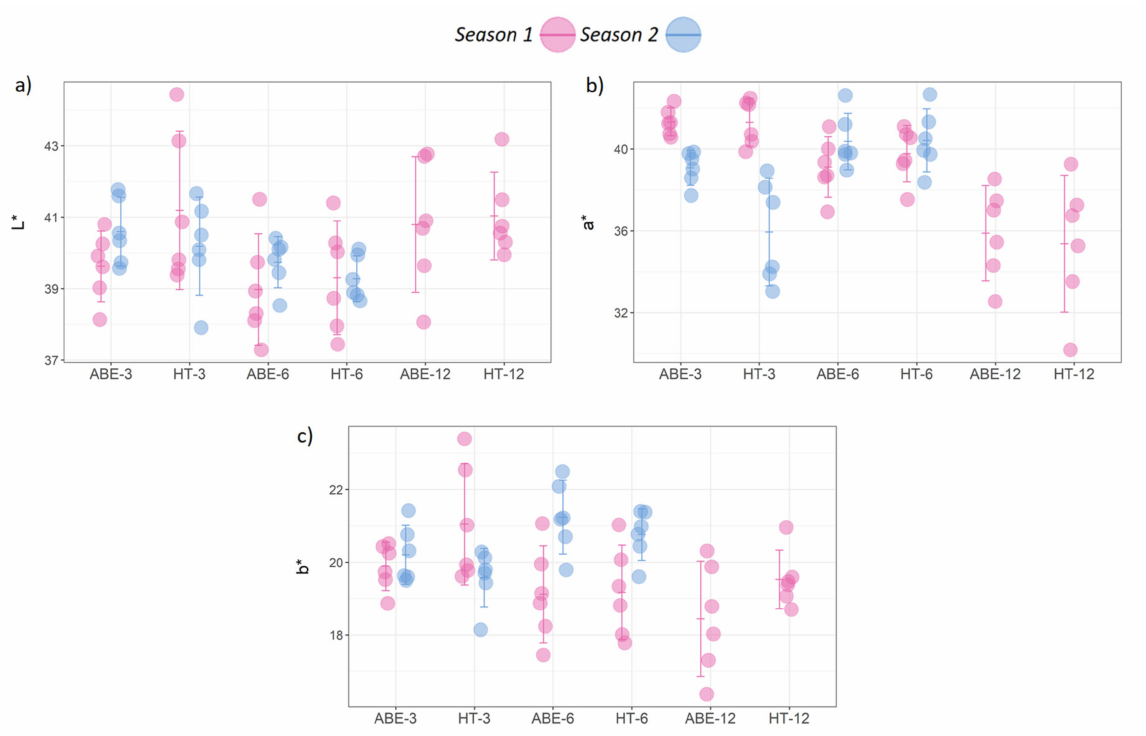
Figure 7. Effect of thinning regime and crop load on fruit color parameters: ( a ) L *, ( b ) a * and ( c ) b * values (error bars represent 95% confidence interval). ABE = artificial bud extinction; HT = hand